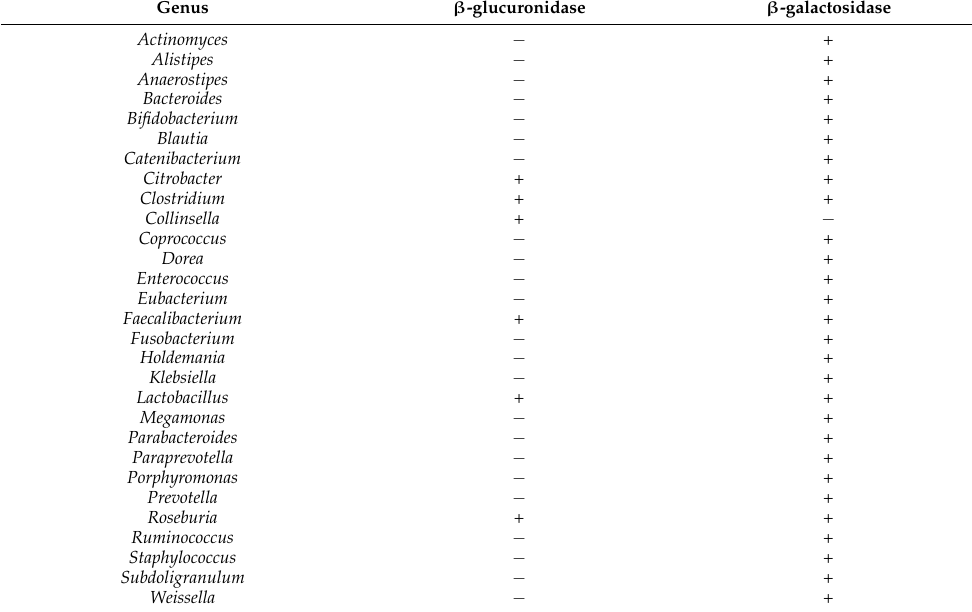
Table 1. Microbiota producing β -glucuronidase and/or β -galactosidase that were used for estrobolome analysis. The data were collected from previous studies on microbiome-related estrogen metabolism. Genus β -glucuronidase β -galactosidase Actinomyces